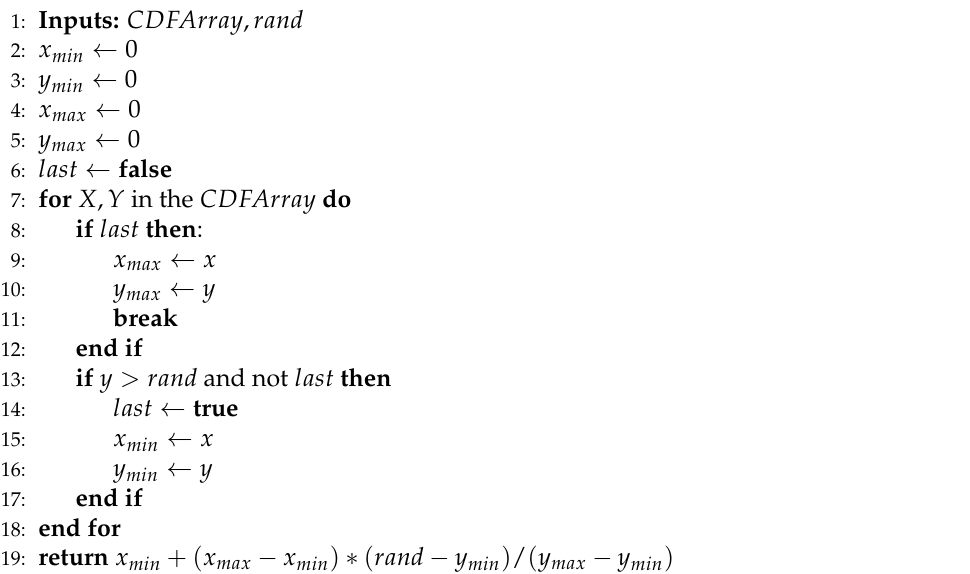
Algorithm 1 Linear interpolation of channel